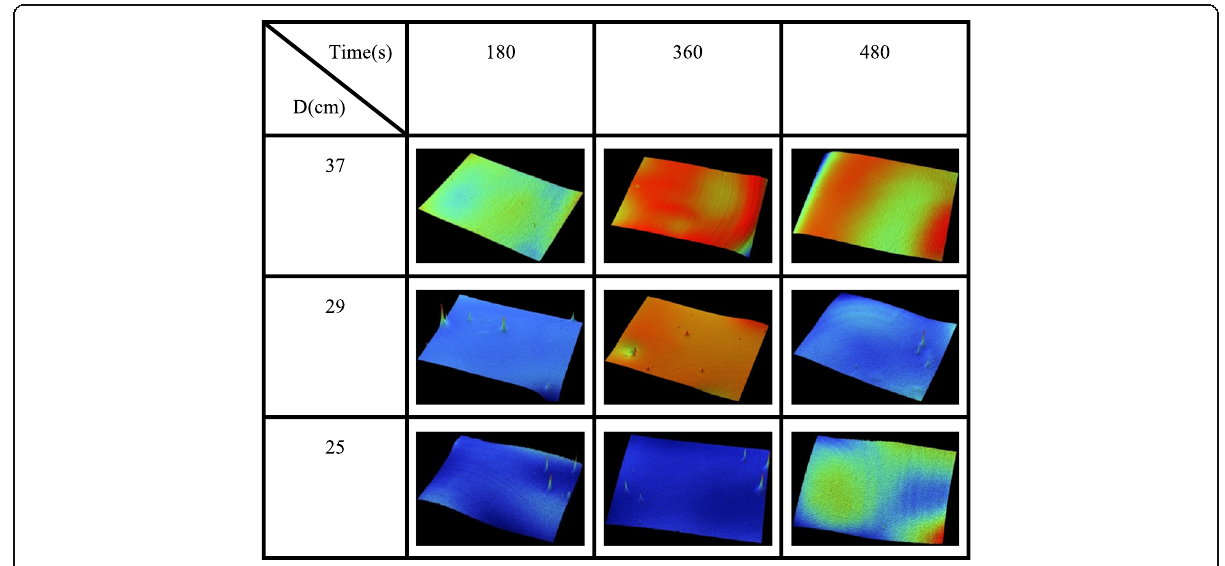
Fig. 5 3D surface morphologies of the silver films at different UV curing conditions